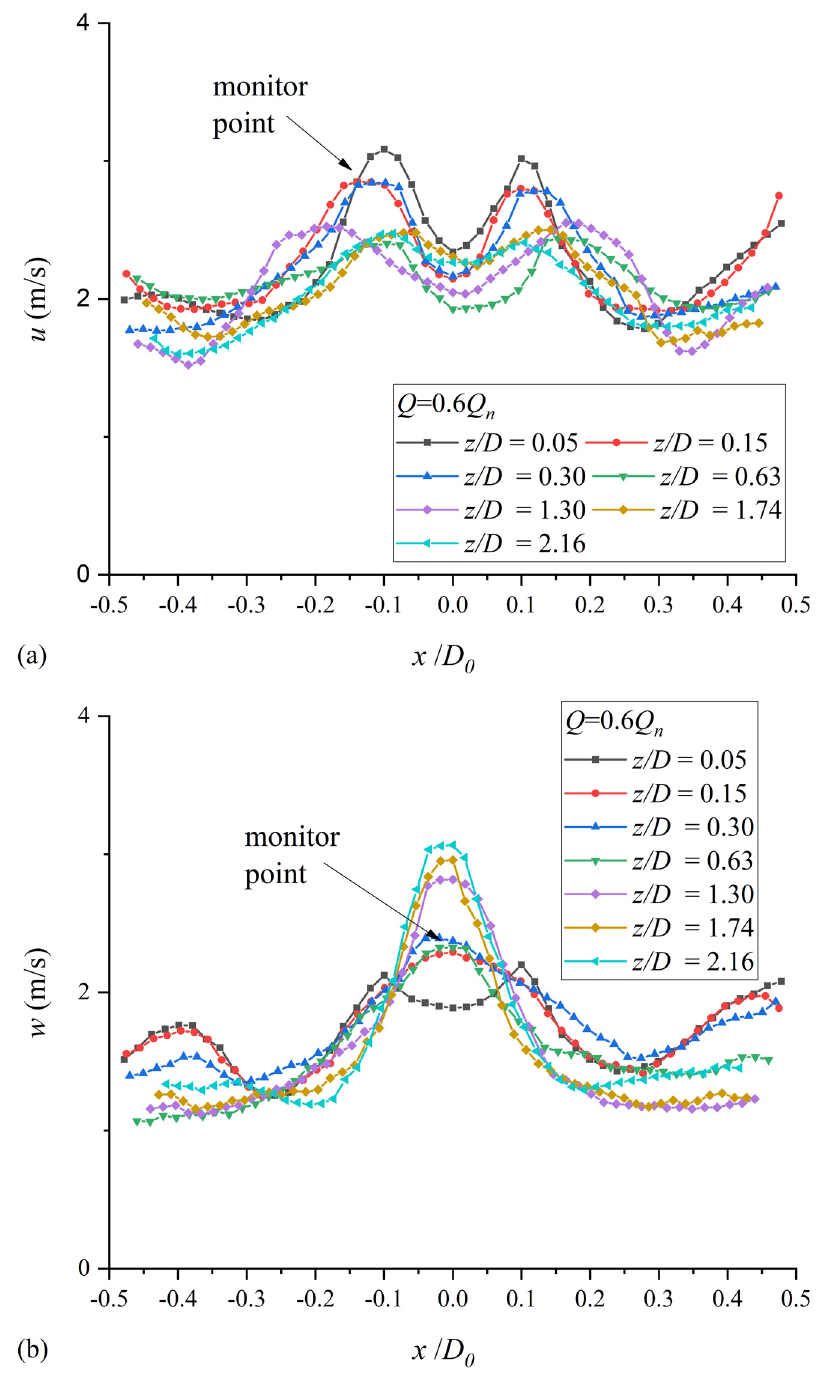
Figure 4. Profiles of the RMS velocity component at different distances from the runner at a constant runner speed ω n : ( a ) Axial component; ( b ) Tangential component. Part load regime with Q = 0.6 Q n .